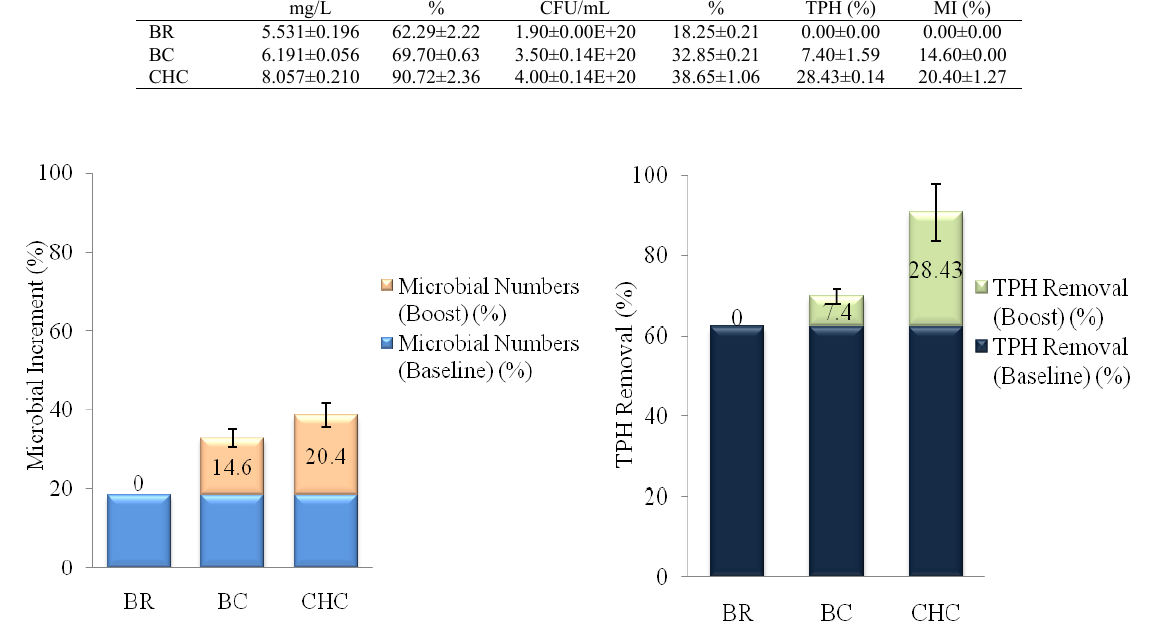
Fig. 2a: BSM impact (Microbial growth) Fig. 2b: BSM impact (TPH removal)